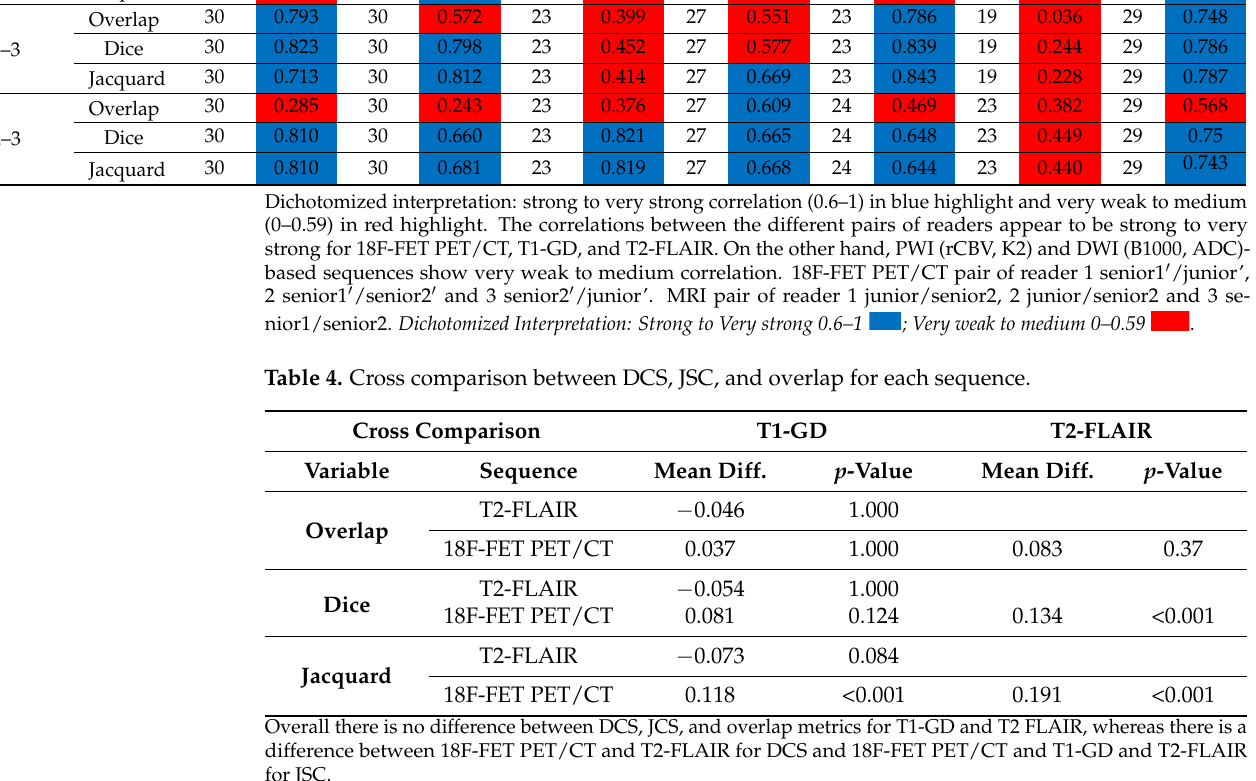
Table 3. The correlations between the different pairs of readers for DCS, JSC, and overlap for each sequence. Spearman’s correlation coefficient.